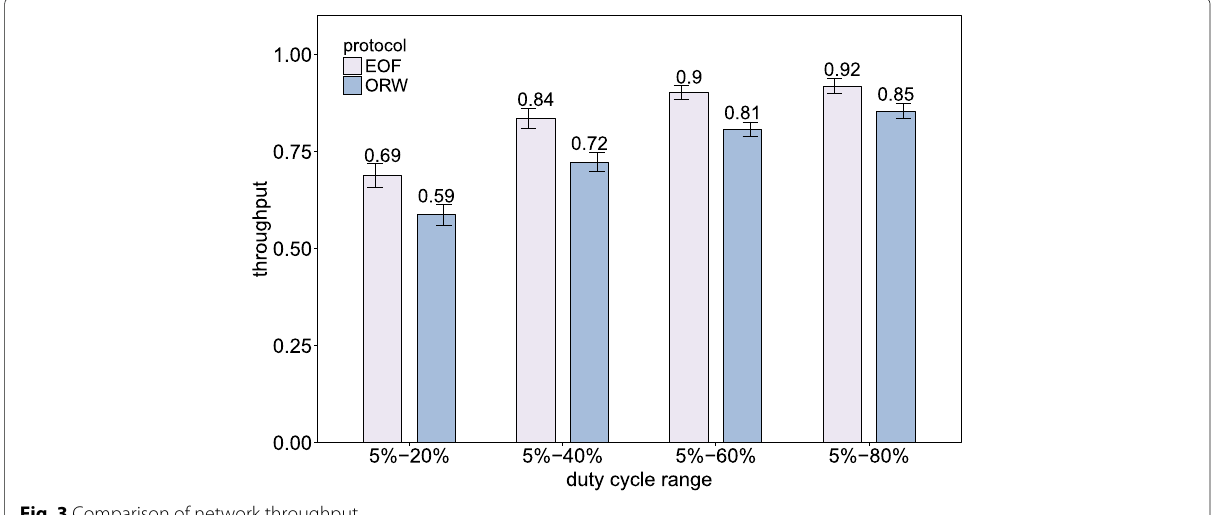
Figure 5 plots the per-node throughput against the node position in an experiment where the sink locates the left bottom corner. In Fig. 5 the color intensity measures the per-node throughput. From Fig. 5 we can see that EOF covers a larger network area than ORW—for the nodes far away from the sink, EOF can forward more packets for them than ORW does. In other words, EOF can achieve better monitoring coverage of the interest